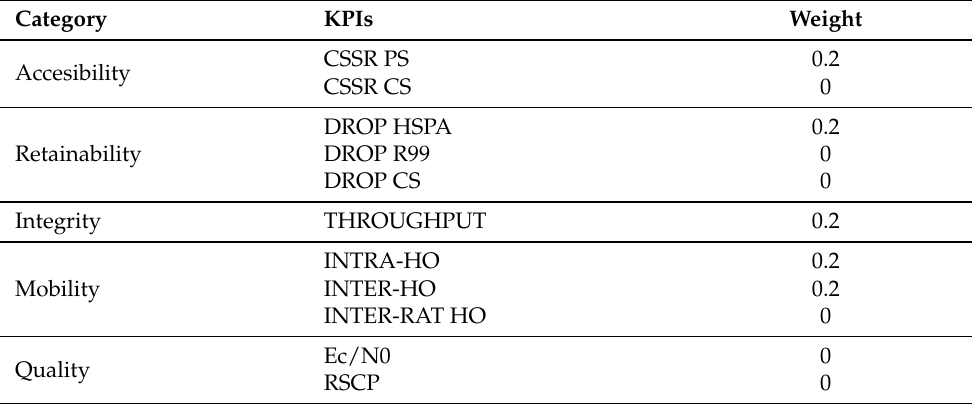
Table 4. Public opinion, PS user. Variables related to data service are